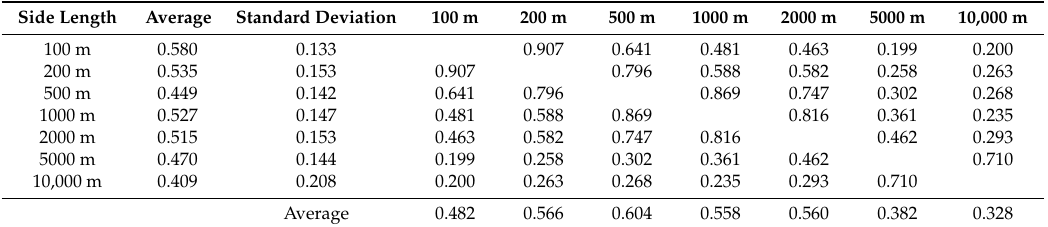
Table 15. Correlation matrix and basic statistic parameters for the 5000 m mesh control points grid. Side Length Average Standard Deviation